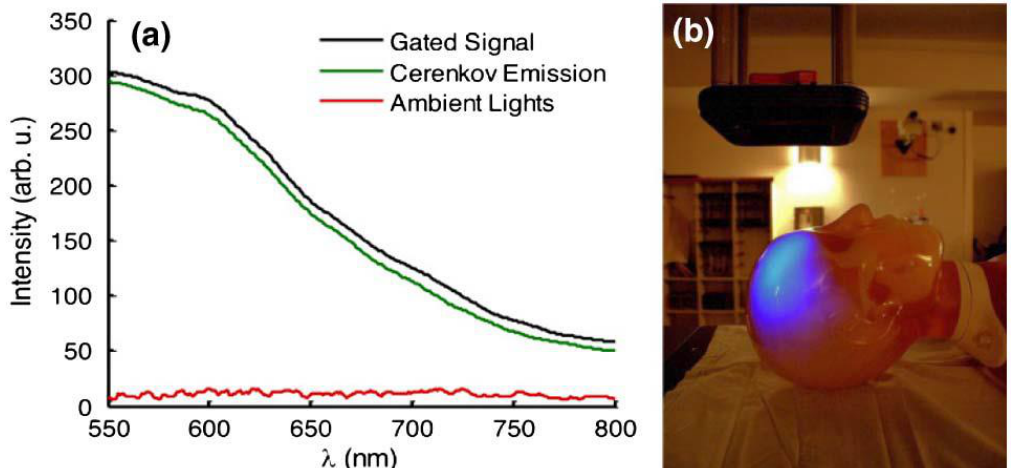
Figure 4. ( a ) The gated detection of Cerenkov emission with room lights on is shown with spectra acquired from a scattering phantom. Cerenkov emission is obtained by calculating the difference between the gated signal and ambient lighting signal. ( b ) A photograph of the room with a corre- sponding image of Cerenkov emission from a human head phantom for radiation therapy overlaid to illustrate the amount of ambient lighting present for all experiments. Reprinted with permission from Ref . [78] . Copyright 2012, Optica Publishing Group.